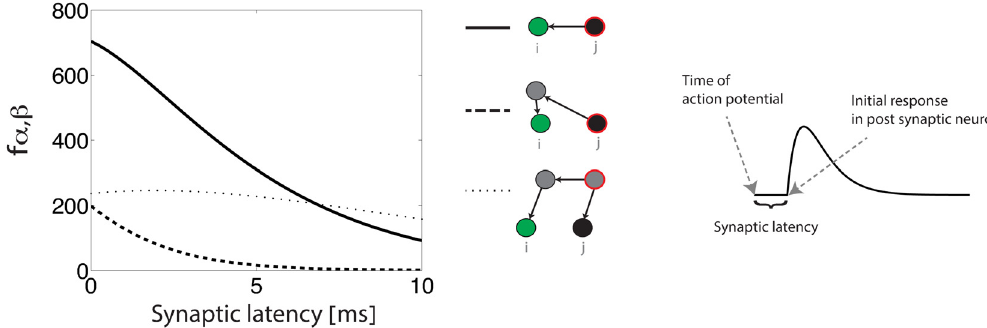
Fig 5. Left: Motif coefficients as a function of the synaptic latency. Solid line — f 1,0 , dashed line — f 2,0 , dotted line — f 2,1 . An antisymmetric STDP function is assumed. Right: the time course of the synaptic current. The synaptic latency is modeled as a delay in the onset of the postsynaptic current, relative to the presynaptic spike time. The precise form of the synaptic current and STDP function are specified in